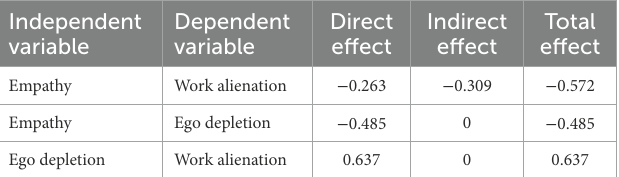
TABLE 4 Direct effect, indirect and total effect of variables